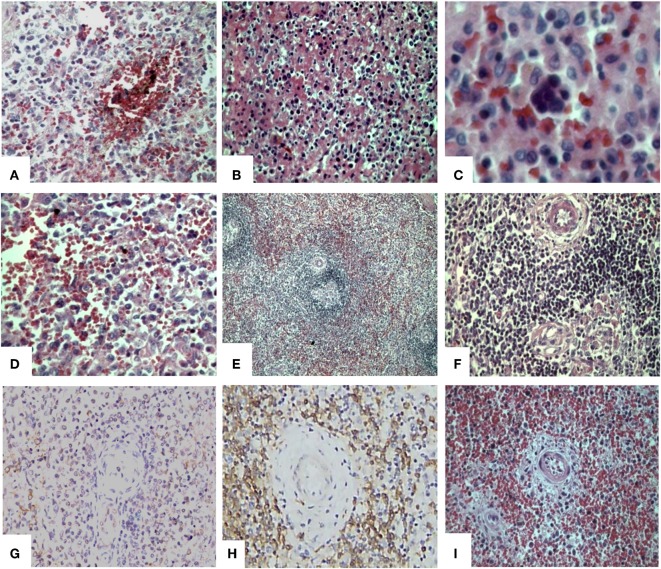
Histological and immunohistochemical findings in the spleen of patients with severe leptospirosis with pulmonary hemorrhage and shock. Spleen from a patient with leptospirosis with (A) congestion, hemorrhage and haemosiderin pigments (HE); (B) acute splenitis with neutrophils, eosinophils, plasma cells, reticular cells, and macrophages (HE); (C) extramedullary haematopoiesis (HE) and (D) hypertrophic and hyperplasic reticular cells and macrophages increased in the red pulp (HE). Control patient with (E) adequate white pulp, with germinative center (HE); and (F) normal T-zone and B-zone (HE); (G) Spleen from a leptospirosis patient with positive IH for Leptospira antigens in the red pulp. Spleen from a bacterial septic patient with (H) white pulp with low TCD8+ density by IH stain and (I) red pulp congestion and atrophic follicles with depleted T-zone and B-zone(HE). Original magnification 400×, except for (C) oil immersion (1000×) and (E) 200×. HE, Haematoxylin-Eosin; IH, Immunohistochemistry.